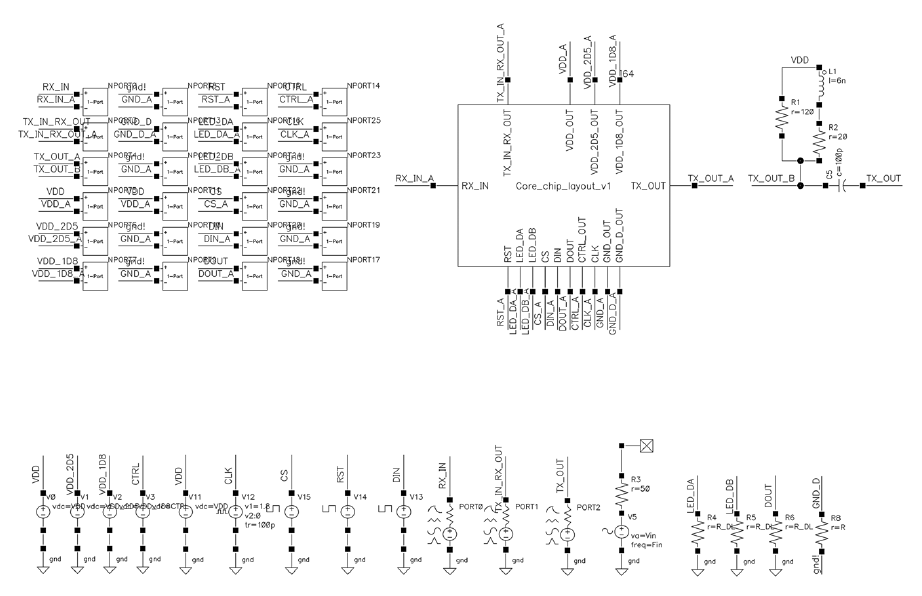
Fig. 4. Core Chip